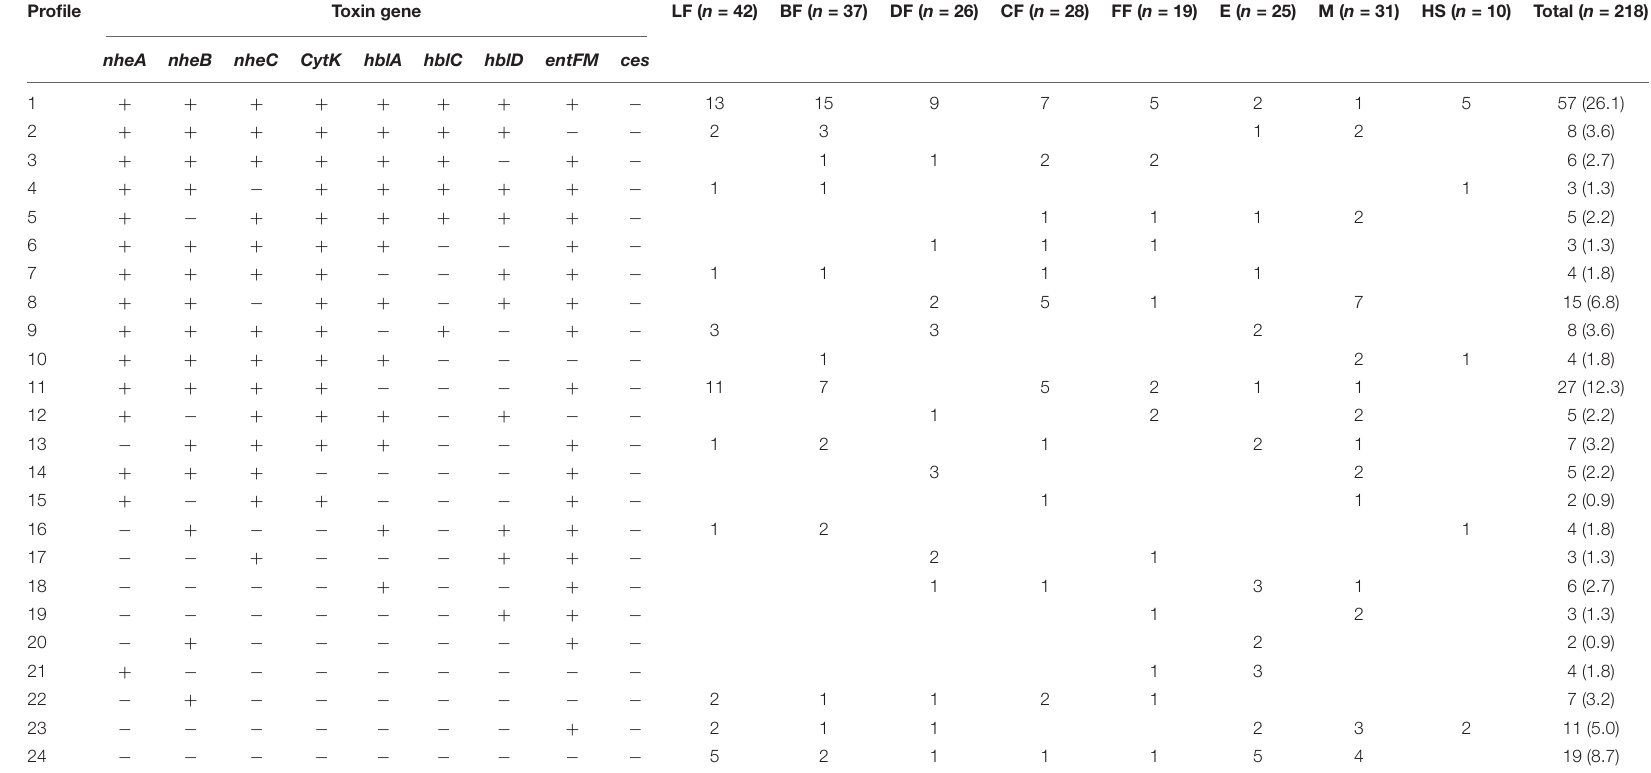
TABLE 5 | Toxin gene profiling of Bacillus spp.